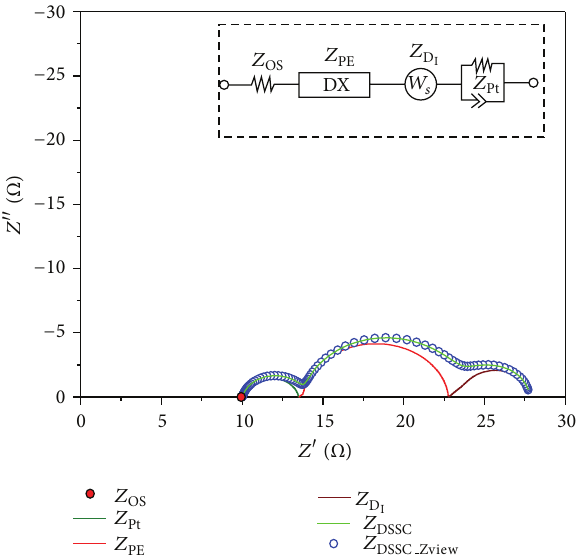
Figure 11: Complex plane plot for the impedance of a DSSC showing calculated impedance of individual components and complete DSSC using parameters as summarized in Table 2. The blue circle shows the EIS spectra simulated on Zview software using the same parameters and according to the equivalent circuit as shown in the inset, where DX is the extended element 11: Bisquert number 2 that corresponds to ) the impedance of the diffusion-recombination process at the PE of DSSCs (𝑍 PE